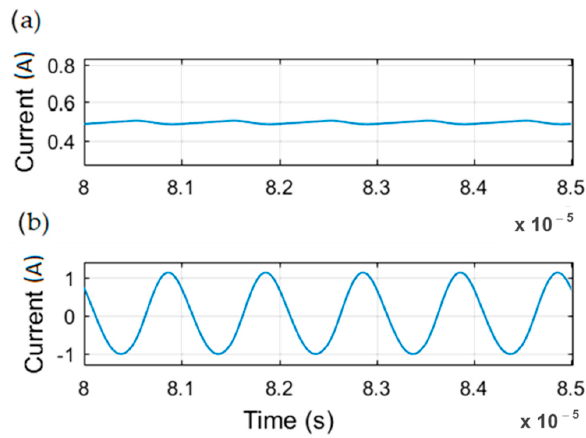
Figure 12. Waveforms of ( a ) input current I d and ( b ) output current I o .